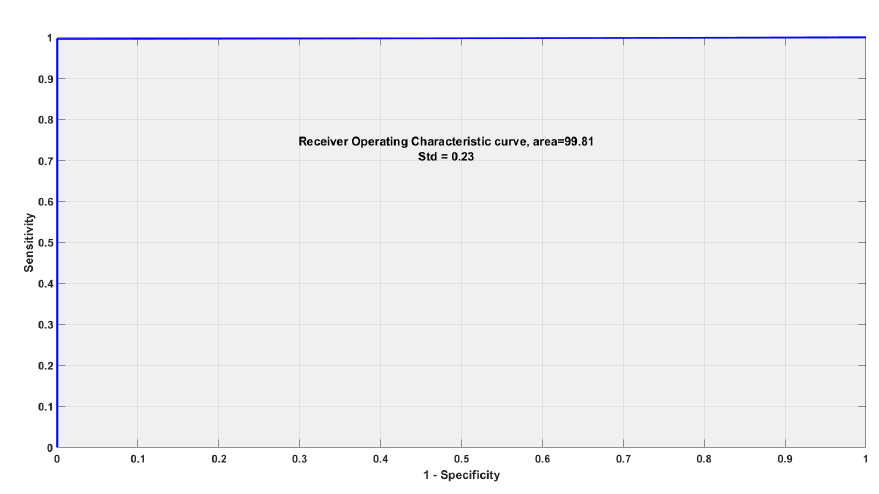
Figure 5. Receiver operating characteristics and the area under the curve obtained for binary classifi- cation of RH and RF